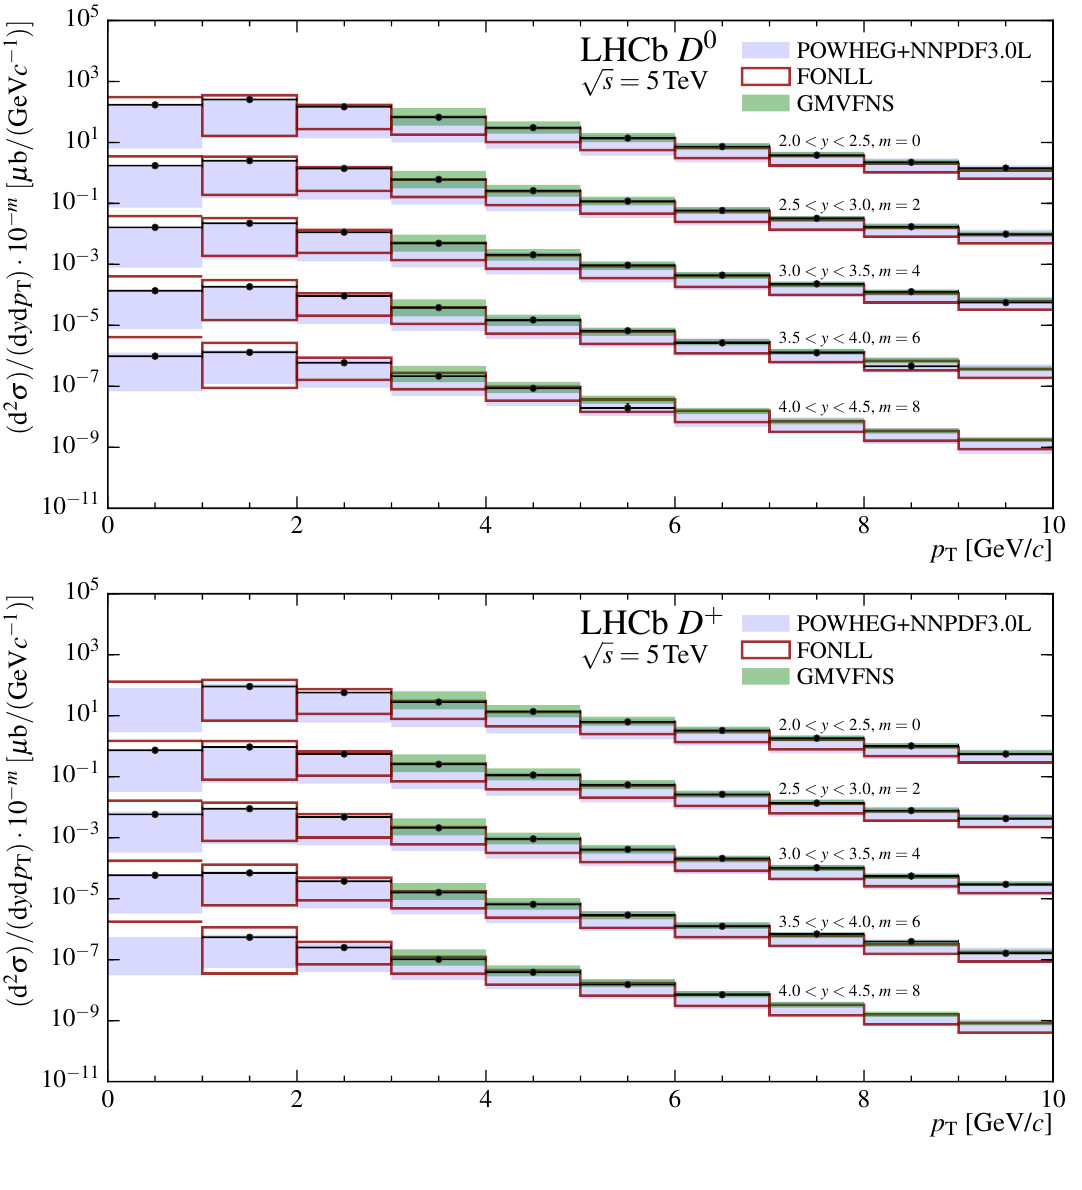
Figure 5. Measurements and predictions for the absolute prompt (top) D 0 , and (bottom) D + cross-sections at p s = 5 TeV. Each set of measurements and predictions in a given rapidity bin is o(cid:11)set by a multiplicative factor 10 (cid:0) m , where the factor m is shown on the plots. The boxes indicate the 1 (cid:27) uncertainty band on the theory predictions, where only the upper edge is shown if the (cid:6) uncertainty exceeds two orders of magnitude.